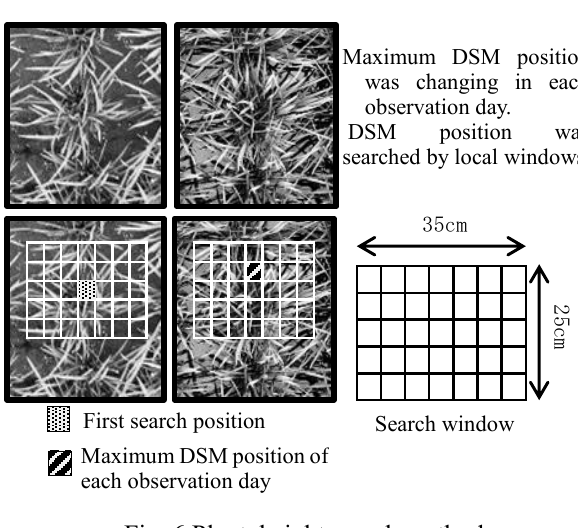
Fig . 6 Plant height search